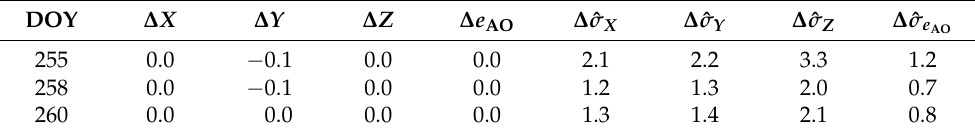
Table 4. Differences between the second-order approximation derived by the SSUT and the linear substitute solution derived by the GMM of the coordinates of the reference point P IRP , the axis offset e AO , and the related standard deviations, i.e., ∆ = SSUT − GMM. All estimates are given in